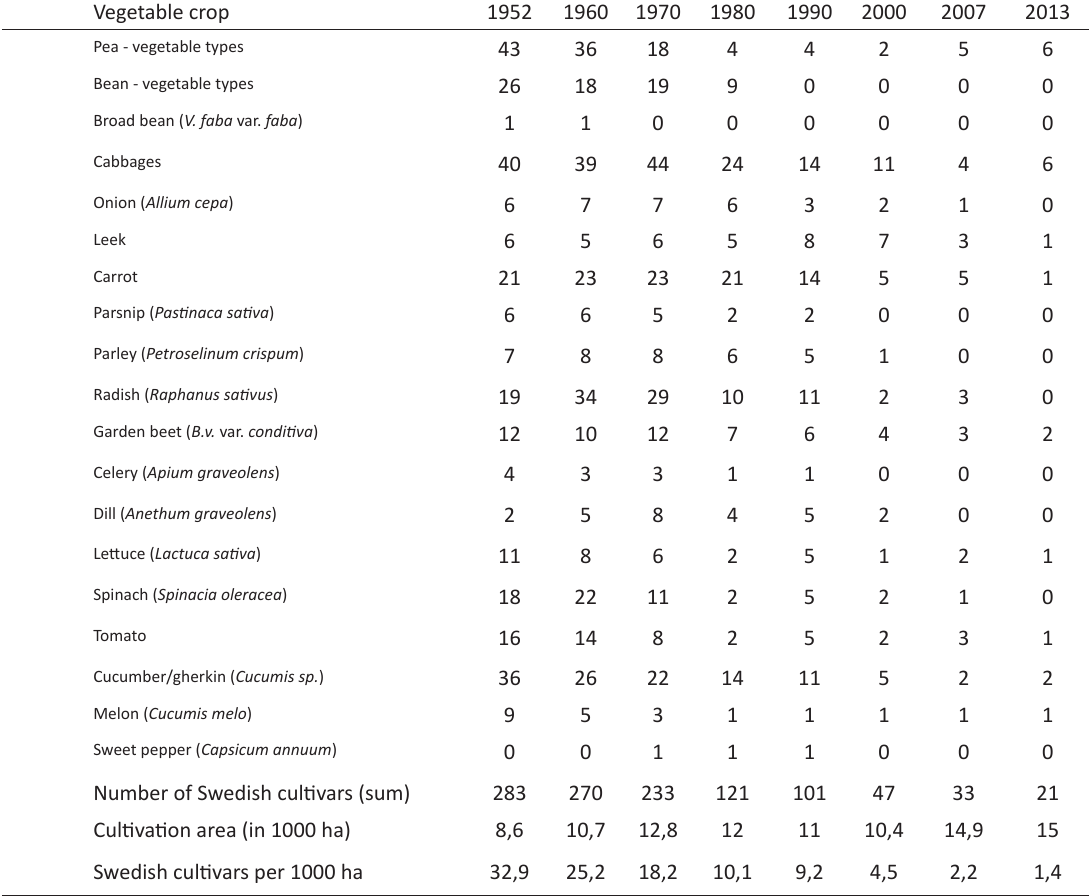
Table 4. Vegetables; number of Swedish bred cultivars on the official variety lists from 1952 to 2013, and cultivation area and number of cultivars per 1000